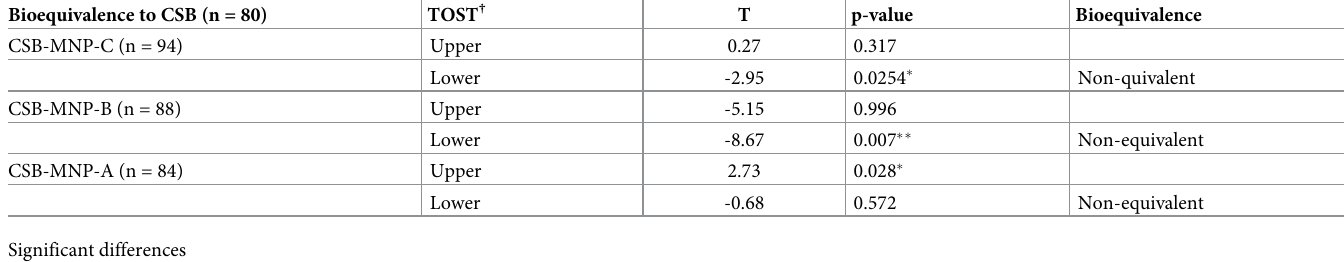
Non-quivalent Non-equivalent 0.572 Non-equivalent